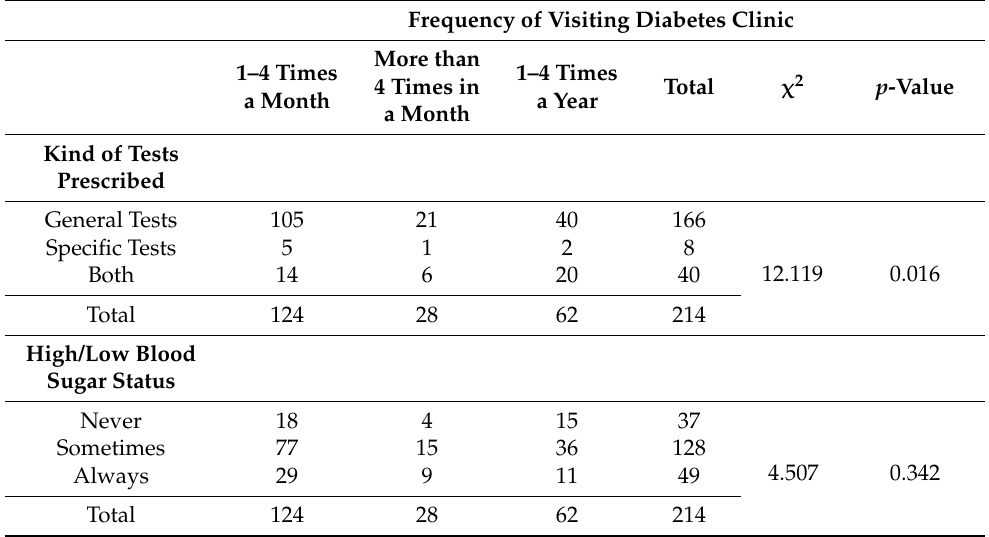
Table 4. Cross tabulation Combination (iii).